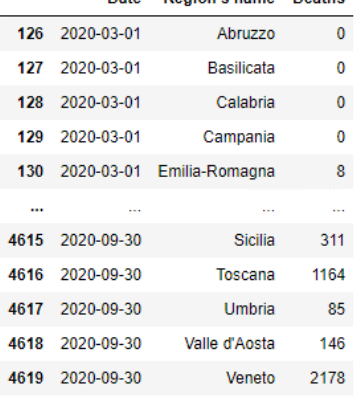
Figure 5. Civil Protection’s dataset of COVID-19 deaths recorded in Italy